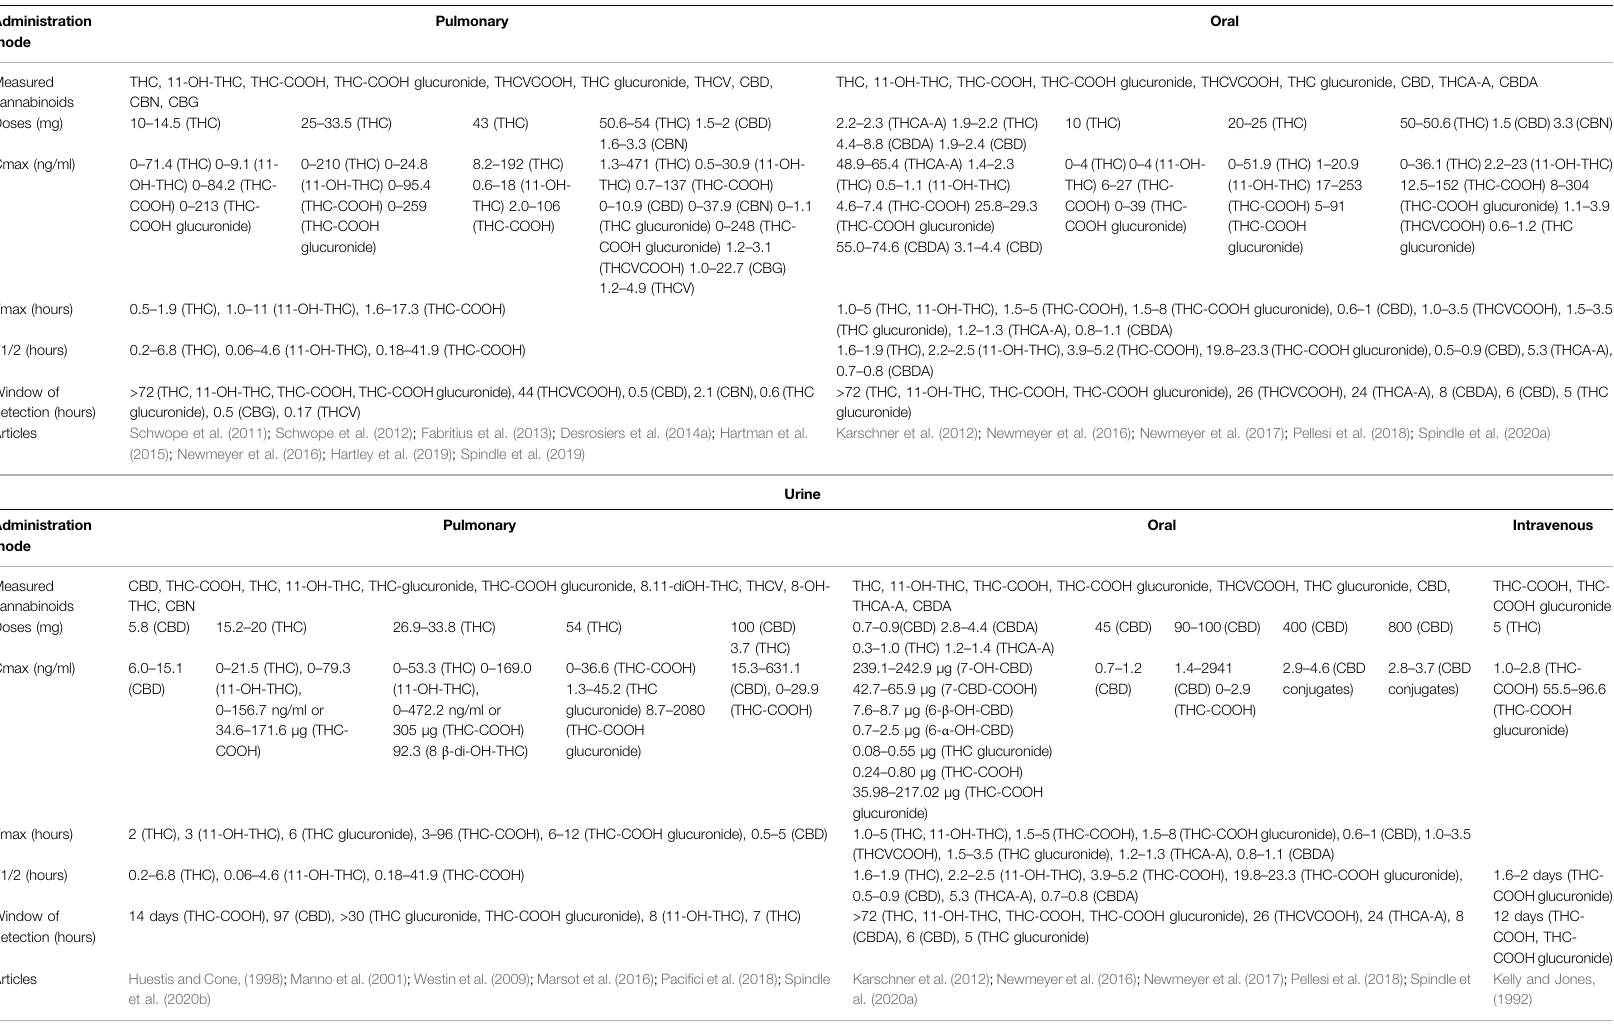
TABLE 1 | ( Continued ) Pharmacokinetics of cannabinoids in the general